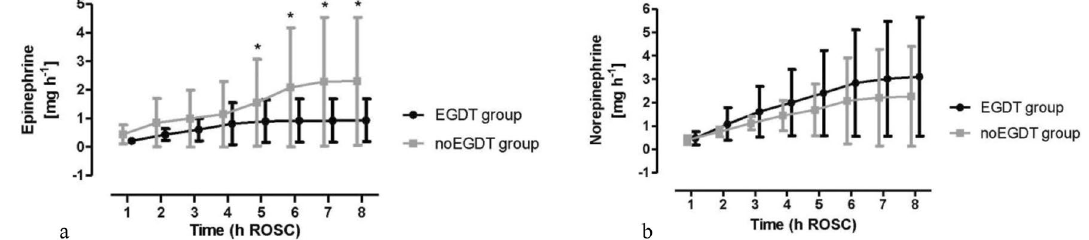
Figure 3. Cumulative consumption of epinephrine ( a ) and norepinephrine ( b ). ROSC return of spontaneous circulation. Bars denote points: PRSW (8 h after ROSC, P < 0.01), EDPVR (4 h after ROSC, P < 0.05), EDV (8 h after ROSC, P < 0.01) and Dp/dt max (4 h after ROSC, P < 0.05; Table 3). The total amount of epinephrine was significantly lower in the EGDT group (Fig. 3a), whereas norepinephrine was used less frequently in the noEGDT group without reaching statistical significance (Fig. 3b). Cardiac TnT levels did not show statistically significant differences between the EGDT and noEGDT group (Fig. 4). LDH at baseline, 2 h, 4 h and 8 h after ROSC showed no significant differences between both groups (Fig. 5). Immediately after CPR, lactate concentrations increased up to 7–10 mmol/l in both groups. Comparison of lactate concentrations between 1 and 8 h exhibited a significant decrease to nearly baseline levels in the EGDT group (1 h vs 8 h ROSC: 7.9 vs. 1.7 mmol/l, P < 0.01), while in the noEGDT group lactate concentrations did not decrease significantly (1 h vs. 8 h ROSC: 9.1 vs. 3.8 mmol/l, P = 0.06; Fig. 6). Total amount of fluids per therapeutic cycle displayed no significant difference between the two groups (EGDT 9.8 ± 11.1 ml/kg, noEGDT 7.6 ± 10.4 ml/kg, P = 0.259; Supplement 2). With respect to target fluid admin- istration, we recorded higher fluid administration in the initial 2 h after ROSC in EGDT animals (Supplement 2). Subanalysis of therapeutic cycles within the EGDT group demonstrated a significant higher volume loading compared to the noEGDT if the targets have been achieved (EGDT: 9.1 ± 11.6 ml/kg vs noEGDT: 3.6 ± 6.9 ml/ kg, P = 0.026; not shown).